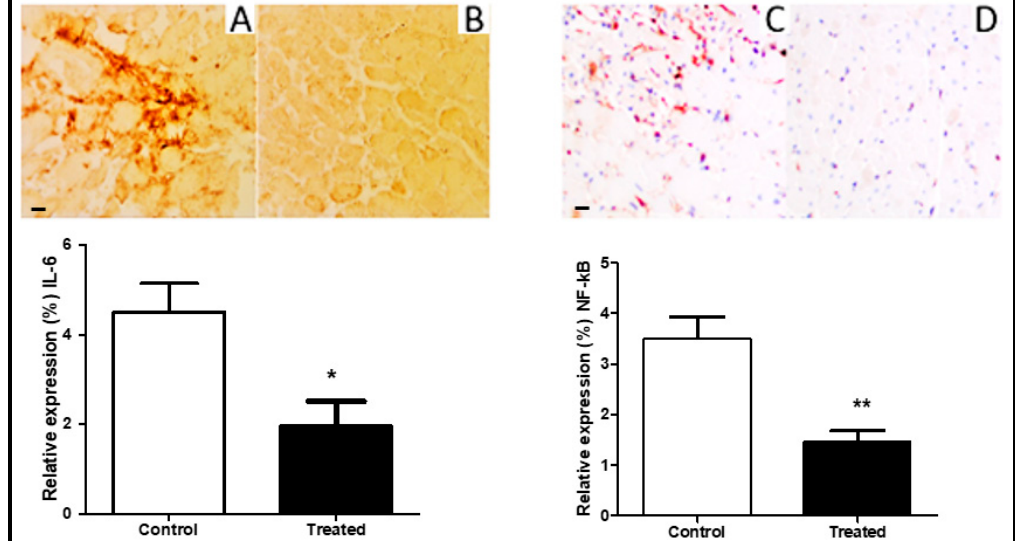
Figure 3. Immunohistochemical analysis showing expression (representative images, 20× magnification) of IL-6 and NF-kB2 in myocardial tissue of cocoa treated rats ( n = 10) compared to control rats ( n = 10), (* p = 0.0032, ** p = 0.0001 respectively). presented as mean ± SD and scale bar is 100 µm. A , B : IL-6, C , D : NF-kB.